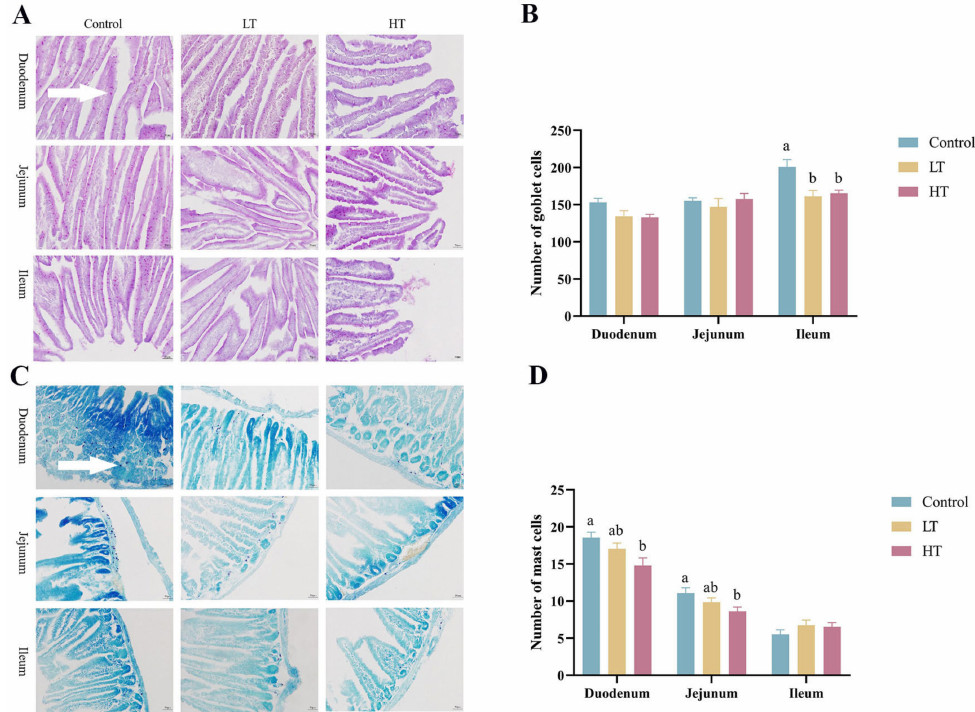
Figure 4. Effect of TA on goblet cell and mast cell counts in small intestine of Brandt’s voles. ( A ) Representative images of PAS-stained histological samples of the small intestine, scale bar = 50 µ m. The white arrow points to goblet cell. ( B ) Number of goblet cells. ( C ) Representative images of TB-stained histological samples of the small intestine, scale bar = 50 µ m. The white arrow points to mast cell. ( D ) Number of mast cells. Control, 0 mg • kg − 1 d − 1 TA; LT, 600 mg • kg − 1 d − 1 TA; HT, 1200 mg • kg − 1 d − 1 TA. a, b Means with different letters differ significantly ( p < 0.05). Data